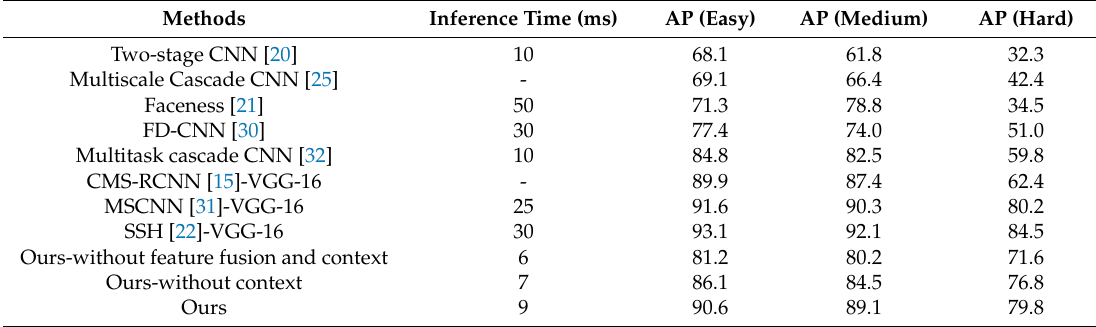
Table 1. Comparison between our method and its state-of-the-art